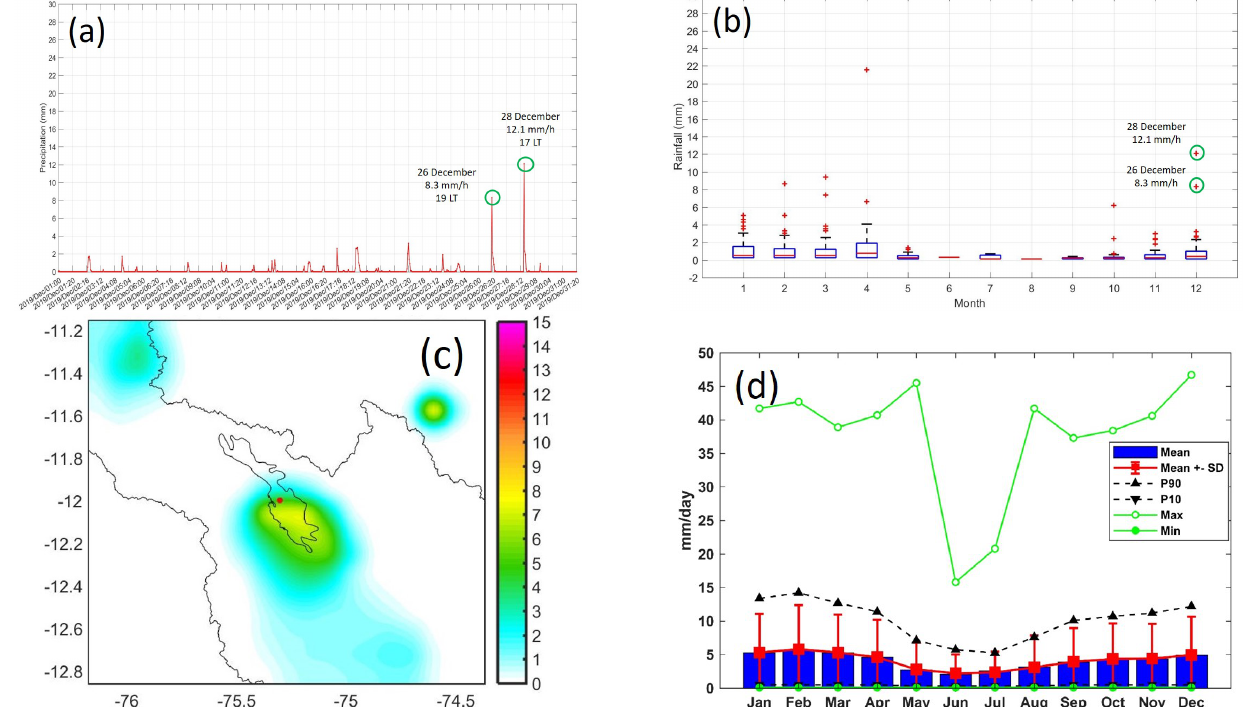
Figure 6. ( a ) Time series of precipitation rate (mm h − 1 ) obtained from an in situ pluviometer (red line) above the HYO during December 2019. ( b ) Monthly variation of hourly accumulated precipitation quantiles (boxplot) above the HYO. Green circles highlight the intensity and time of both rainfall events on 26 and 28 December 2019. The rainfall values are outliers that greatly exceed the mean monthly precipitation of January close to 0.5 mm h − 1 . ( c ) Spatial distribution of precipitation rate (mm h − 1 ) for the MV obtained from the GPM data for 28 December 2019, at 18 LT. Longitudes, latitudes and contours of the MV and MRB are indicated. The red circle indicate the location of the HYO. ( d ) Mean, maximum, minimum, percentile 10%, and percentile 90% of daily accumulated precipitation (mm day − 1 ) between 1965 and 2019 on the